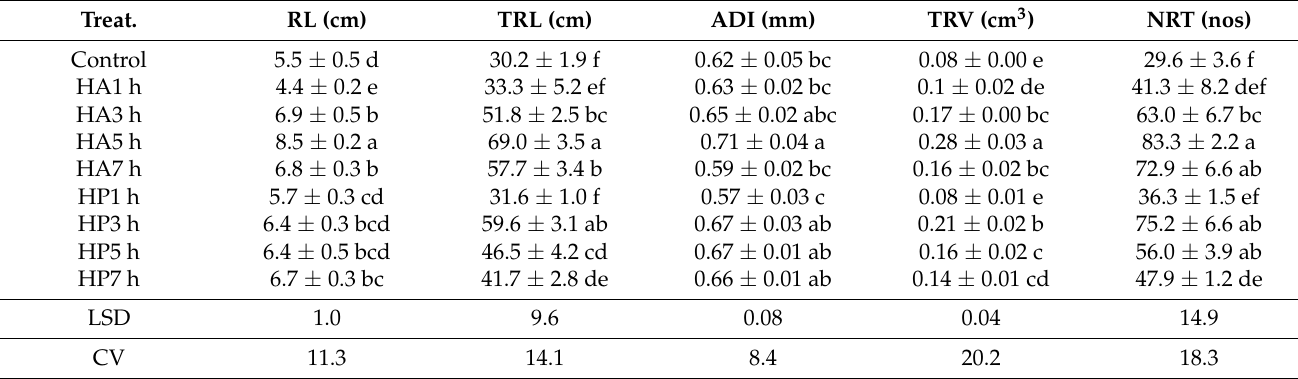
Table 6. Root morphological characteristics of the soybean seedlings on the 7th day after sowing.